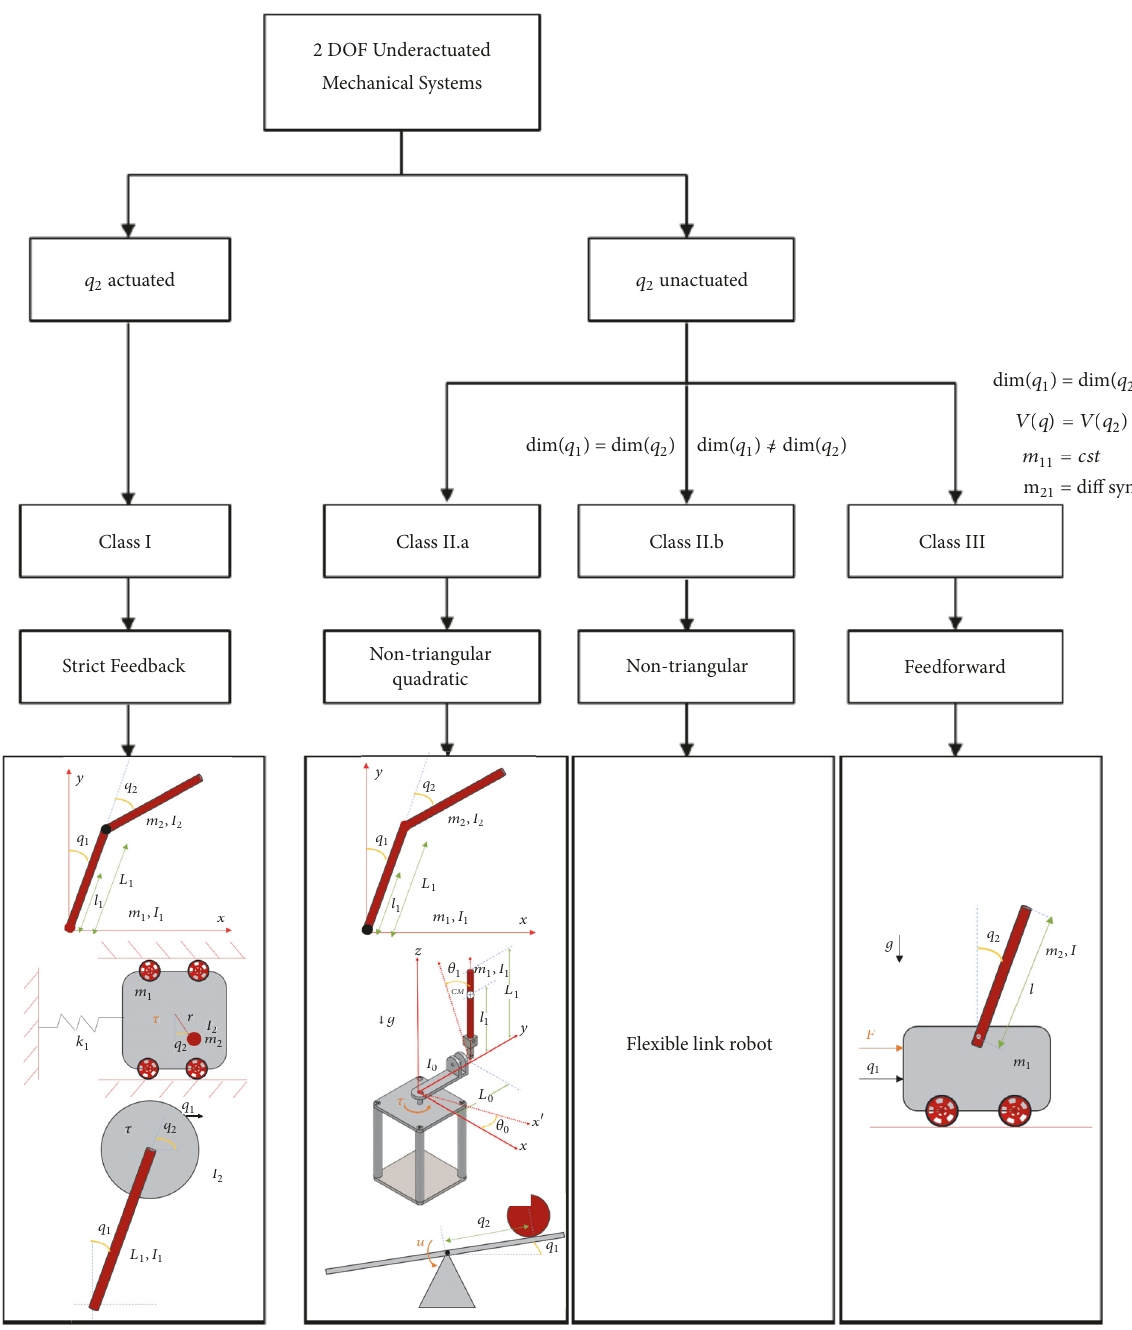
Figure 7: Classification of 2 degrees of freedom underactuated mechanical